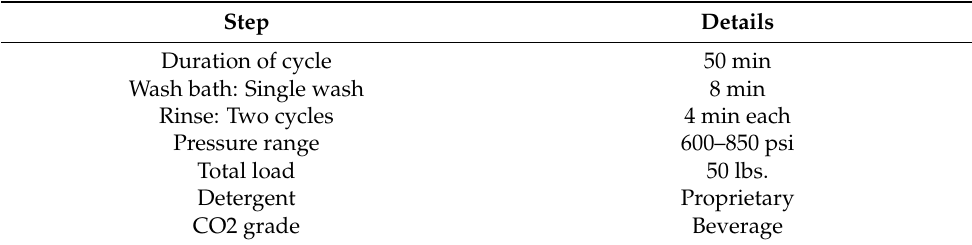
Table 2. Details of the liquid CO 2 method.